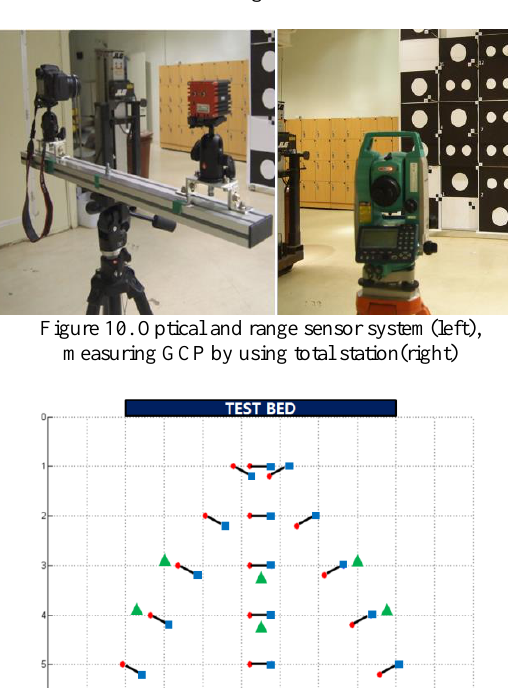
Figure 12. can be interpreted